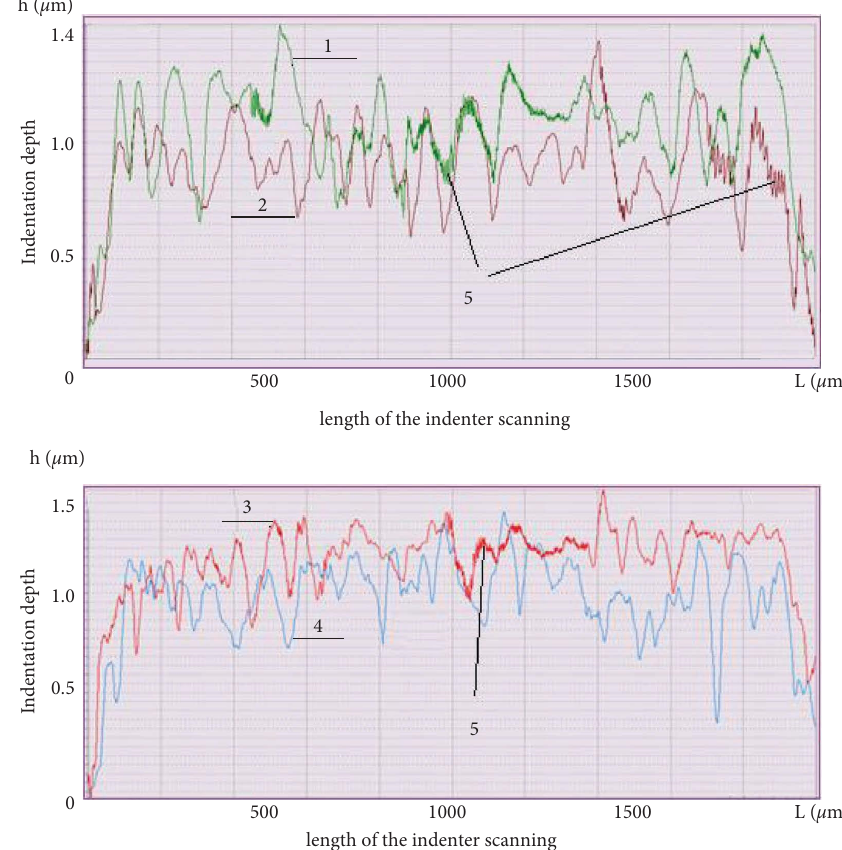
Figure 9: Indentation depth during sclerometry: lubrication with sample 1: leading (1) and lagging (2) surfaces, lubrication with sample 2: leading (3) and lagging (4) surfaces, and sample 5: areas of heterogeneous deformation